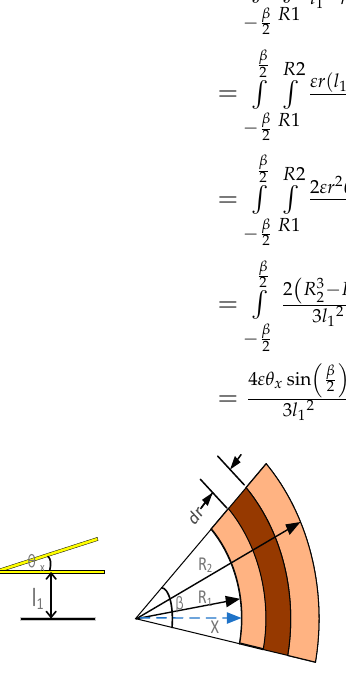
Figure 9. Schematic diagram of the sensing capacitance.